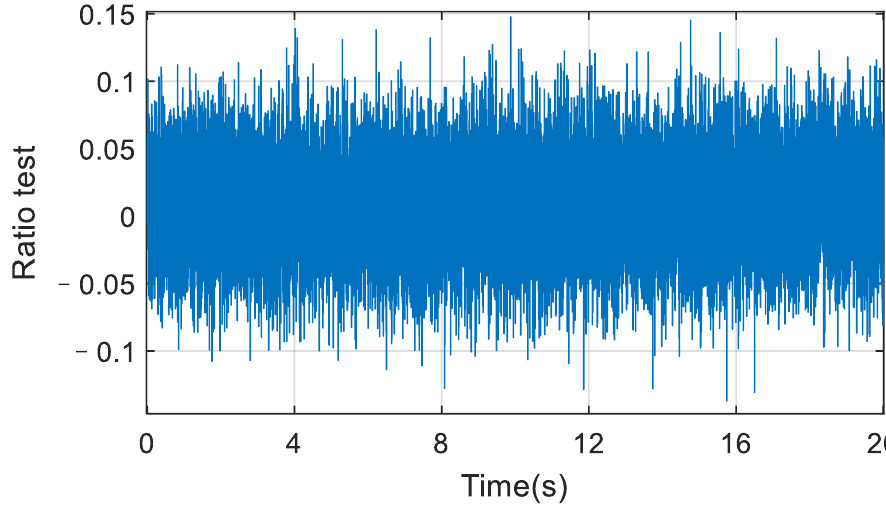
Figure 23. Ratio Test metric behavior under traction Strategy 2.